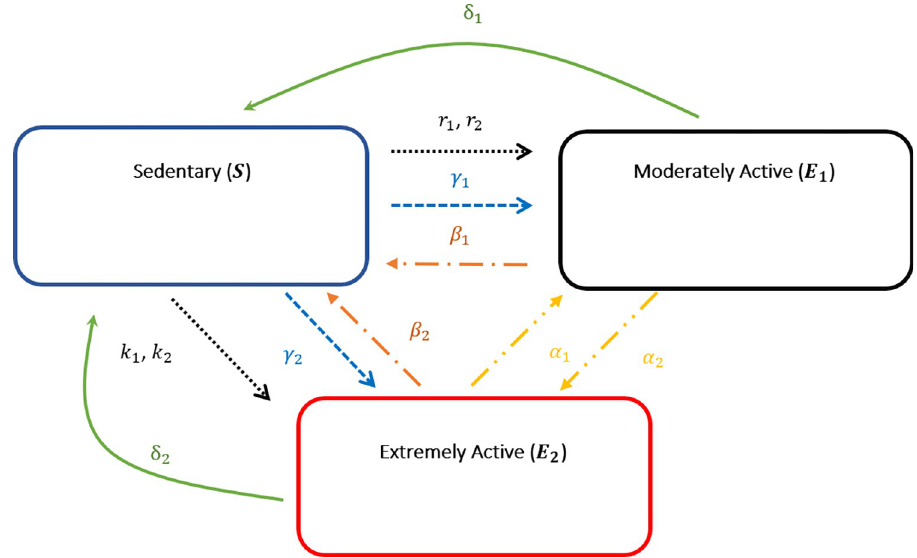
Fig 1. Flow diagram describing model transitions between state variable